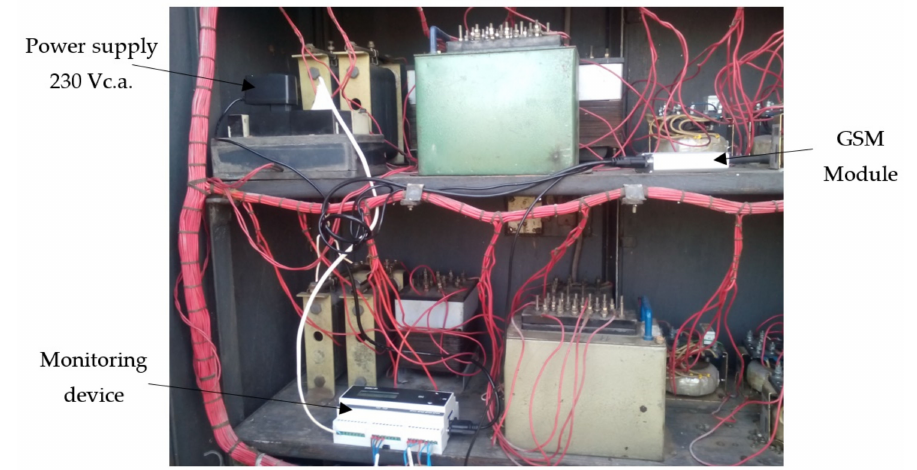
Figure 11. Image of the monitoring device in the relay cabinet from the